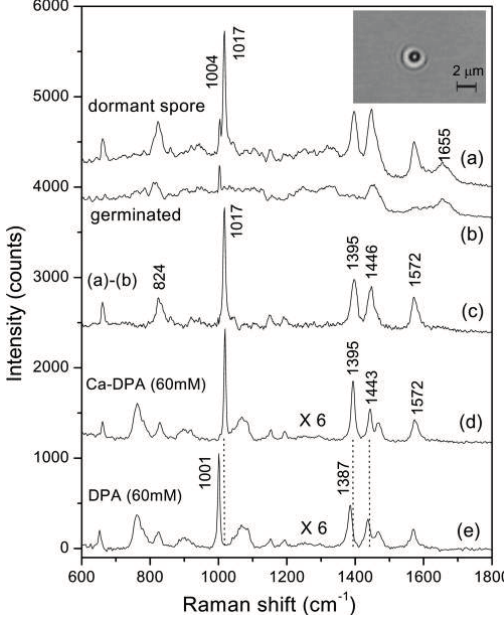
Figure 17. Raman spectra of ( a ) dormant; and ( b ) germinated B. subtilis spores; ( c ) subtraction of curve b from curve a; ( d ) The Ca-DPA; and ( e ) DPA Raman spectra [96] (With permission from American Society for